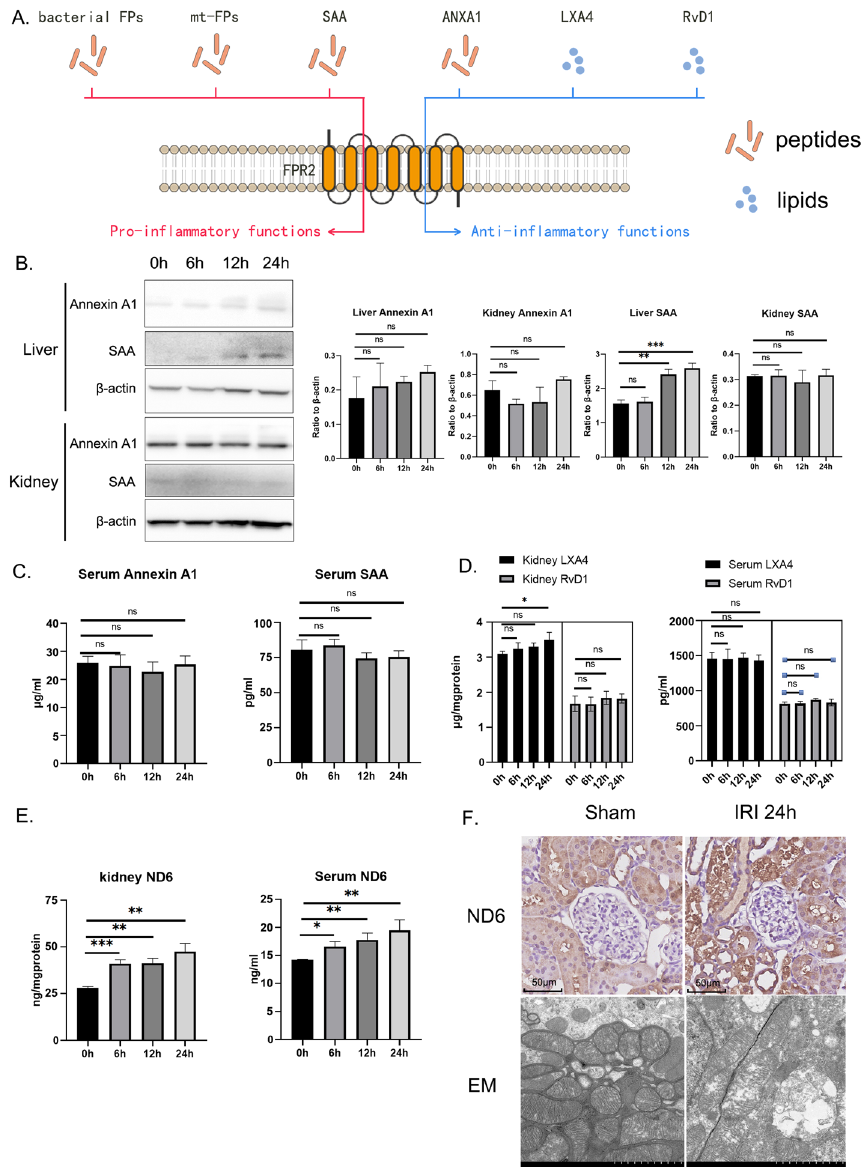
Fig. 3 mtFPs are dominative FPR2 agonists in the acute phase of IRI. The left renal pedicle of the rat was clamped for 45 min to induce IRI. The right kidney was removed before releasing the clamps. WRW 4 was administered intravenously 30 min before surgery. Liver tissues, kidney tissues, and peripheral blood were collected at 0, 6, 12, and 24 h after surgery. A Illustration of FPR2 agonists in a rat model. B At 0, 6, 12, and 24 h after surgery, the levels of ANXA 1 , SAA, and β-actin in IRI rat liver and kidney tissues were determined by western blot analysis. C At 0, 6, 12, and 24 h after surgery, the levels of ANXA 1 and SAA in IRI rat serum were measured via enzyme-linked immunosorbent assay. D At 0, 6, 12, and 24 h after surgery, the levels of LXA 4 and RvD1 in IRI rat kidney and serum were measured via enzyme-linked immunosorbent assay. E At 0, 6, 12, and 24 h after surgery, rat kidney and serum samples were collected. Kidneys were dissected and finely minced in Hank’s buffer containing 10% type IV collagenase, and the supernatant was collected as kidney interstitial tissues. Levels of ND 6 in IRI rat kidney interstitial tissues and serum were measured via enzyme-linked immunosorbent assay. F At 0 and 24 h after surgery, rat kidneys were collected for immunochemistry staining of ND 6 expression in kidneys and to obtain electron microscopy images of mitochondria in tubular cells. * P < 0.05, ** P < 0.01, *** P < 0.001. ns, P >